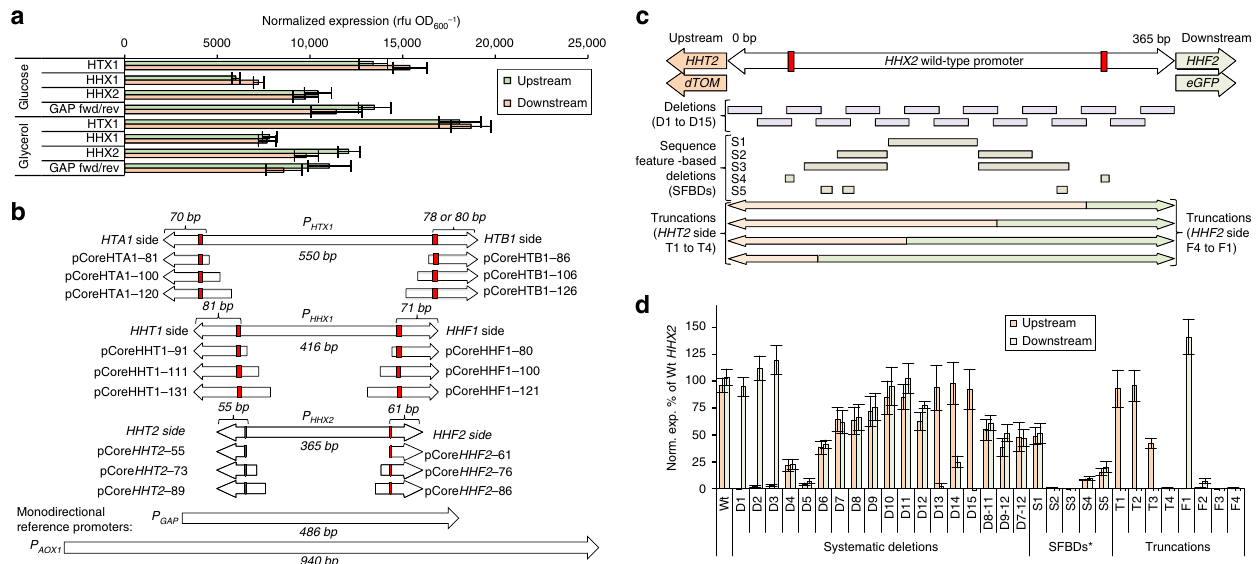
Fig. 2 Natural bidirectional histone BDPs as promoter engineering framework in P. pastoris . a The HTX1 , HHX1 , and HHX2 promoters match (on glucose) or even exceed (on glycerol) the monodirectional P GAP promoter. Reporter protein fl uorescence of the bidirectional HTX1 , HHX1 , and HHX2 promoters in comparison to the strong, monodirectional GAP reference promoter in P. pastoris . Cells were grown for 60 h on 1% (w/v) glucose or glycerol in 96-well plates. P GAP was cloned in forward (fwd) and reverse (rev) orientation and is hence not bidirectional. The reporter protein fl uorescence is normalized per biomass (determined by OD 600 measurements) to rule out effects of different biomass yields between the carbon sources. b Bidirectional histone promoters are short compared to the commonly used monodirectional GAP and AOX1 promoters (all elements are drawn in the same scale). The histone promoters contain TATA boxes (red rectangle highlighting the yeast TATA box consensus sequence TATAWAWR 37 ) and feature exceptionally short core promoters (pCore … and lengths indicated) useful as parts repository for promoter engineering (Figs. 3a, 4). c , d Owing to their short length, the P. pastoris histone BDPs are easily amenable to promoter engineering as exempli fi ed with the HHX2 promoter. Systematic deletions and truncations of the P HHX2 offer shortened variants with altered cumulative expression levels and ratios. c A schematic on the sequence variants is shown (Supplementary Data 2 for exact positions). TATA boxes are denoted by red rectangles. d Expression levels after growth for 60 h on glucose are shown. *SFBD sequence feature-based deletions (i.e., AT/GC-rich regions and TATA boxes). In a , d , mean values and standard deviations of normalized (using the normalization factor calculated in Supplementary Fig. 1) reporter protein fl uorescence measurements of biological quadruplicates grown on the respective carbon sources are